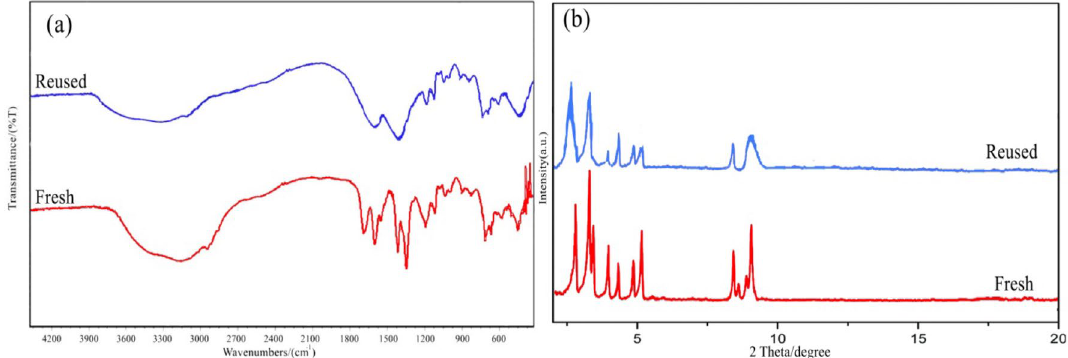
Figure 8. FT-IR spectrum ( a ) and XRD pattern ( b ) of the recovered HMTA-BAIL@MIL-101(Cr) after 6 runs.